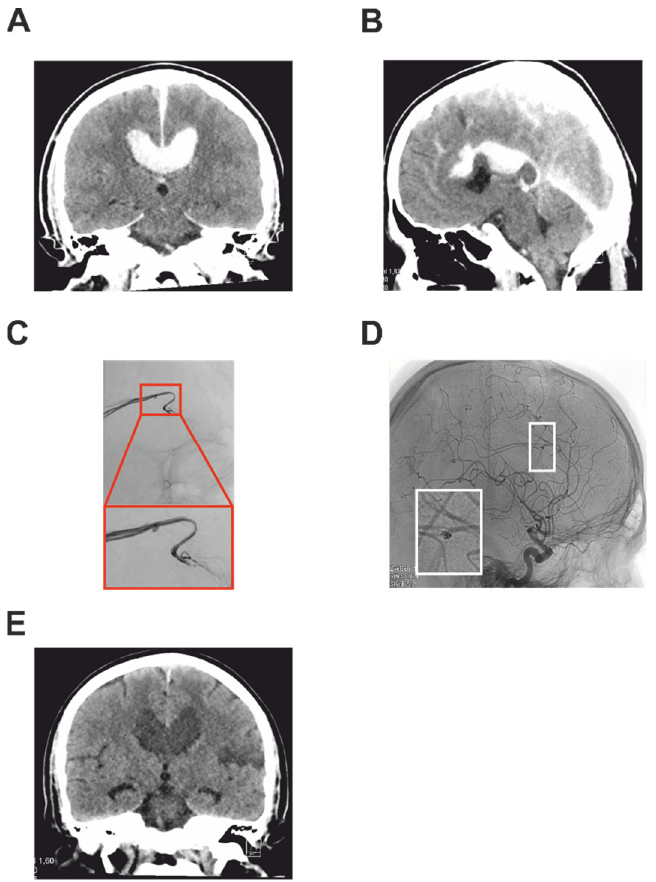
Figure 2. Imaging studies describing Case 2. Post-traumatic preoperative CT of the head showing intracerebral pericallosal hematoma in coronal ( A ) and sagittal section ( B ). DSA investigation of the tIPA of the pericallosal artery together with the detailed view in the red box ( C ). DSA after the coiling of the pseudoaneurysm with a detailed view in the white box showing the coils ( D ). Control coronal CT showing the hematoma one month after the trauma ( E ).